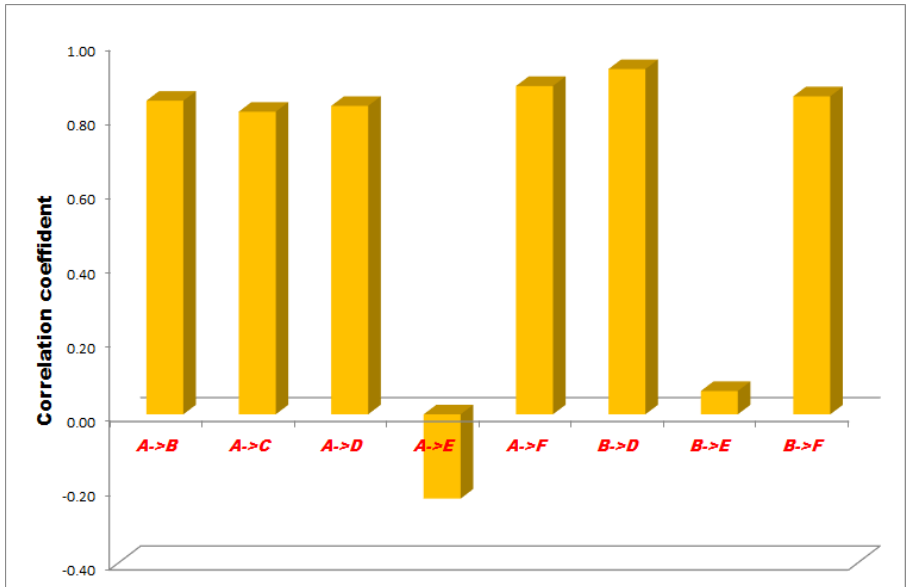
Figure 4. Results of statistical (correlation) analysis between the different sensor pairs during NPWT applying at 100 mmHg suction. Sensors represent exact measurement points in the abdominal cavity. A: midline, above the layer; B: midline, under the layer; C: laterally, above the layer; D: laterally, under the layer; E: midline, among the bowels; F: laterally, among the bowels.